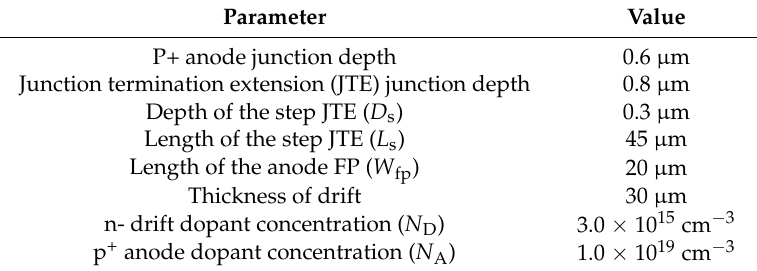
Table 1. Major optimized parameters of the proposed structure.